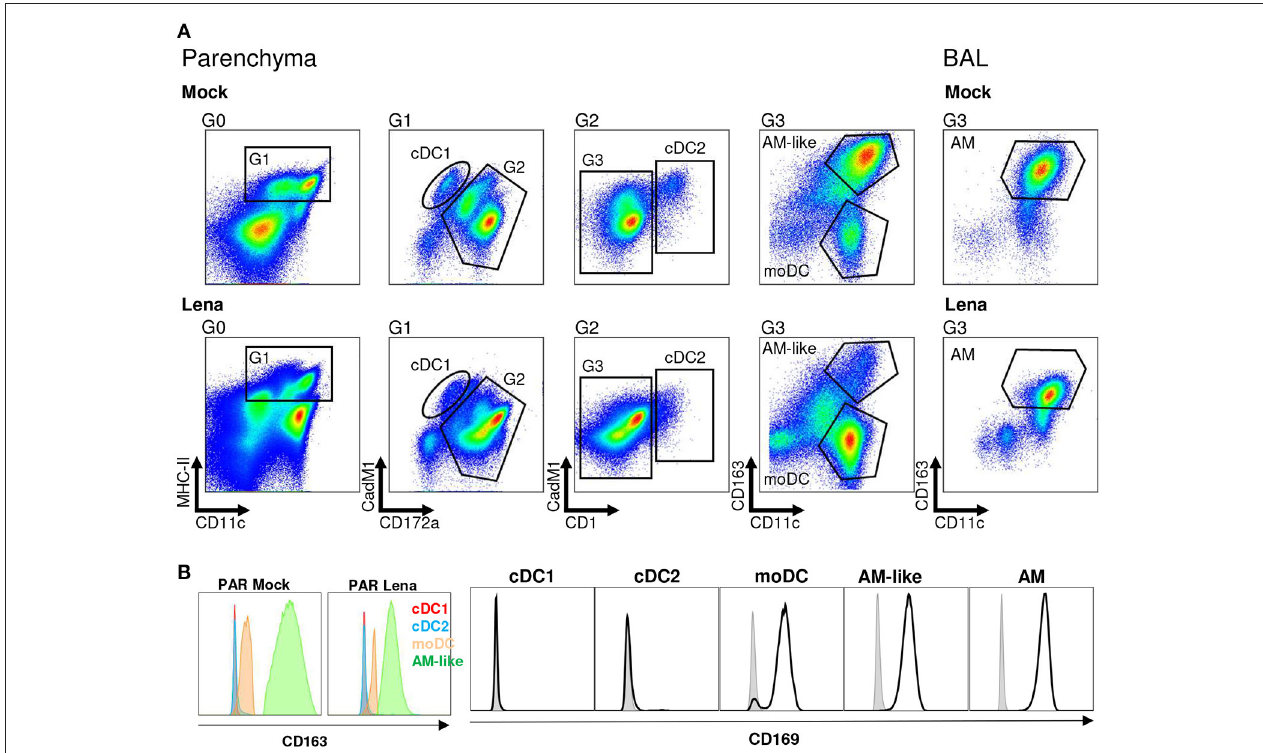
FIGURE 1 | Mononuclear phagocytes (MPC) cell-sorting strategy. (A) Type 1 and Type 2 conventional dendritic cells (cDC1 and cDC2 respectively), monocyte-derived DCs (moDCs) and alveolar macrophages-like cells (AM-like) were isolated in infected or mock-infected lung parenchyma (PAR). MPC were defined by using MHC-II/CD11c/CD172a/CadM1/CD1 and CD163 markers. Identical process was performed on broncho-alveolar lavage (BAL) to collect alveolar macrophages (AM). Each graph is the offspring of the previous gate from left to right. Gates are numbered as G0 to G3. Data are representative of 4 independent cell-sorting experiments. (B) CD169 expression in MNP (Open black histogram) compared to isotype control (Closed gray histogram) and CD163 expression in MNP. Since CD163 is used in the gating of the different MNP populations, isotype control cannot be